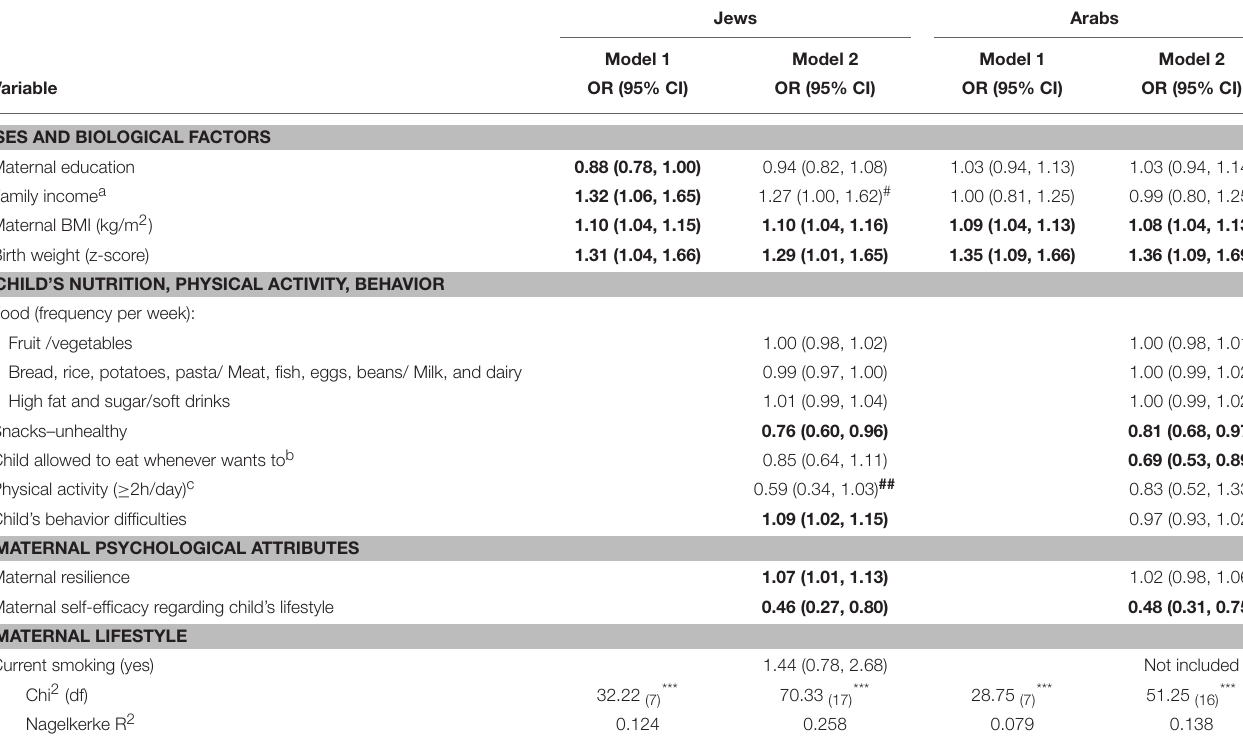
TABLE 3 | Predictors of child overweight/obesity in Jewish ( n = 364) and Arab ( n = 572)